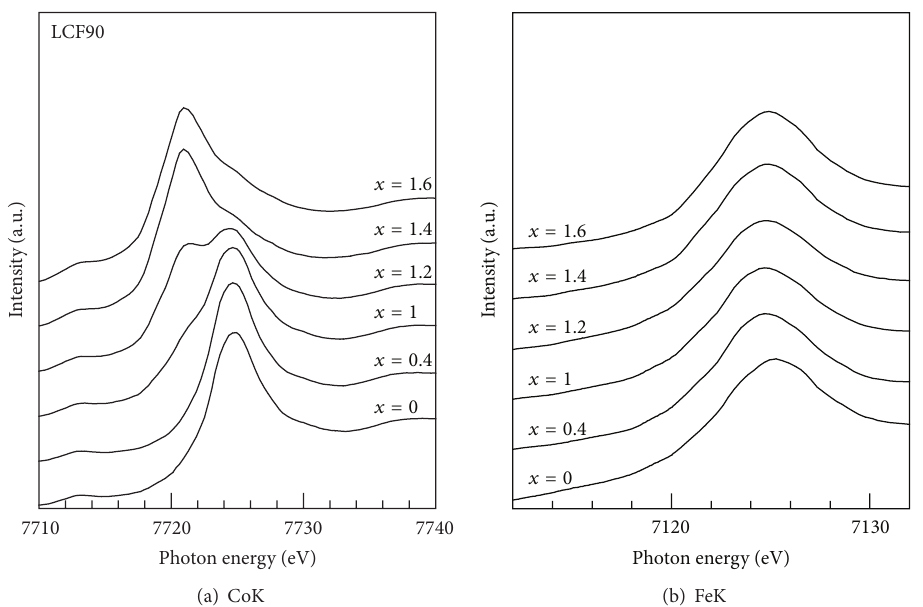
Figure 11: XAS spectra of LCF90 films against 𝑥 around the (a) Co K- and (b) Fe K-edges (cited from